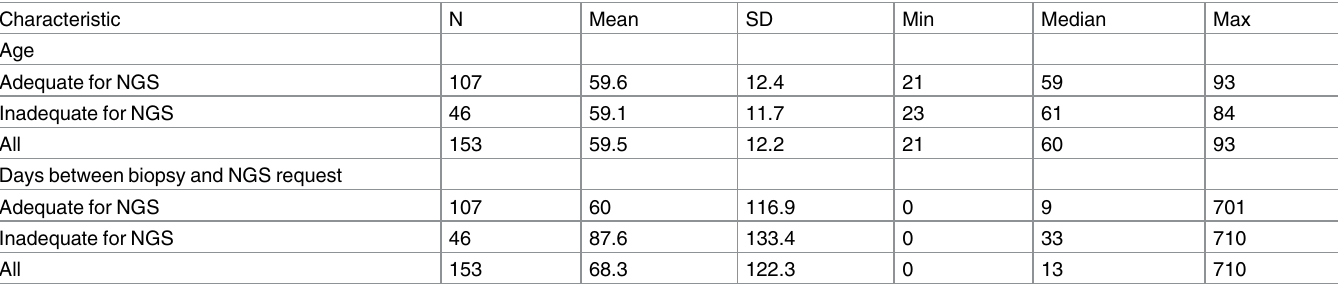
Table 3. Patient age and days between biopsy and NGS request with adequacy for NGS of biopsy specimens.